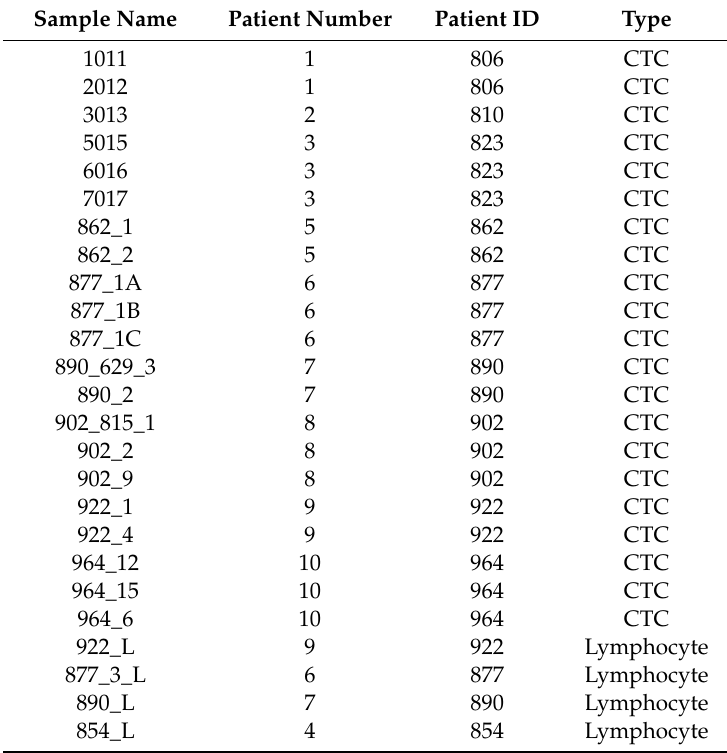
Table 1. List of the 25 samples sequenced: 21 CTCs and 4